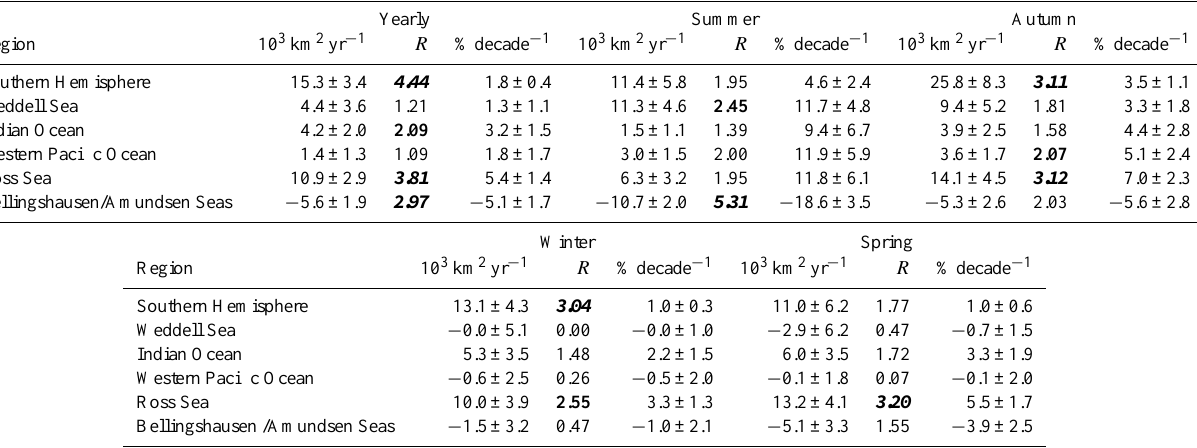
Table 2. Slopes and standard deviations of the lines of least squares fit for the yearly and seasonal sea ice areas in the Southern Hemisphere as a whole and in each of the five regions delineated in Fig. 2, for the period 1979–2010. R is the ratio of the magnitude of the slope to the standard deviation; in the R column, bold indicates statistical significance of 95% and above, and the combination of bold and italics indicates statistical significance of 99% and